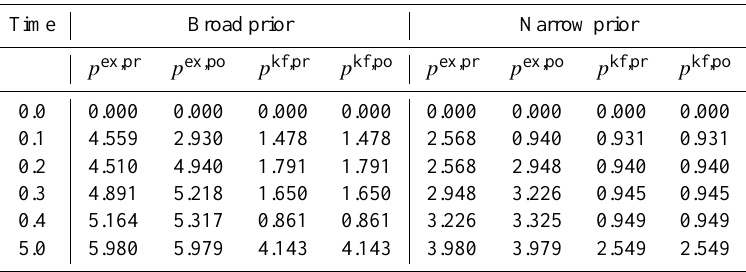
Table 1. The degree of freedom Eq. (8) for various distributions described in the text.